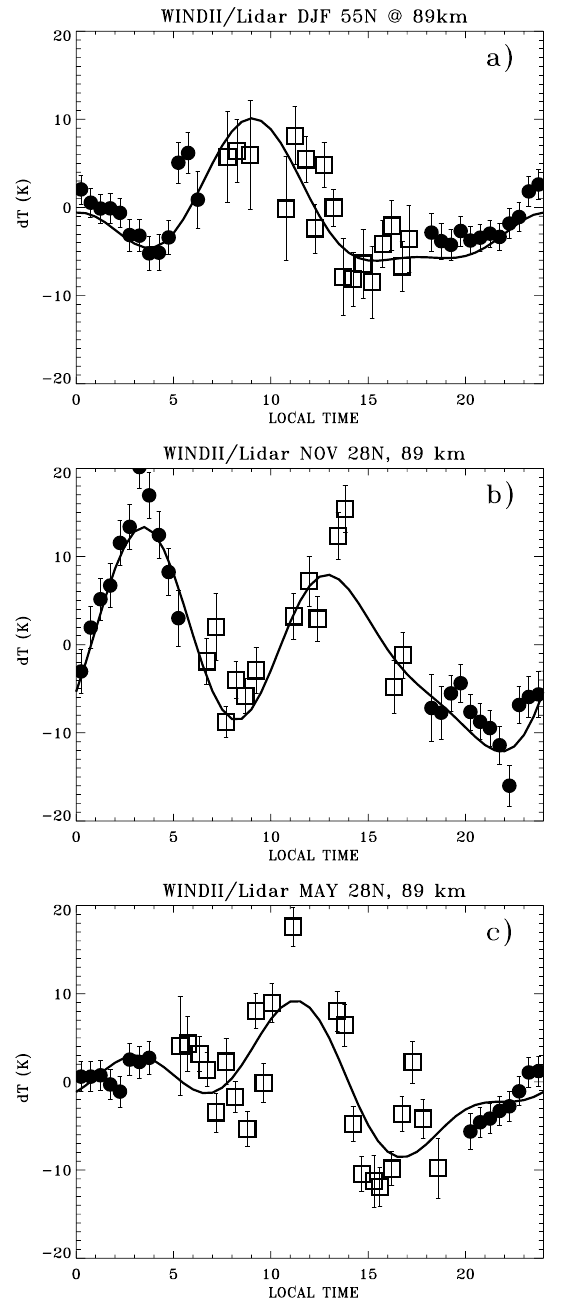
Fig. 5. Combined (24h+12h+8h) tidal fit (solid line) to the potassium-lidar nighttime temperatures (solid circles) and the WINDII daytime temperatures (squares) for: (a) December- February; (b) November, and (c) May. the phase and amplitude of the semidiurnal tide varies from station to station even in a narrow latitude band of ∼ 5 ◦ , as was reported by Jacobi et al. (1999).